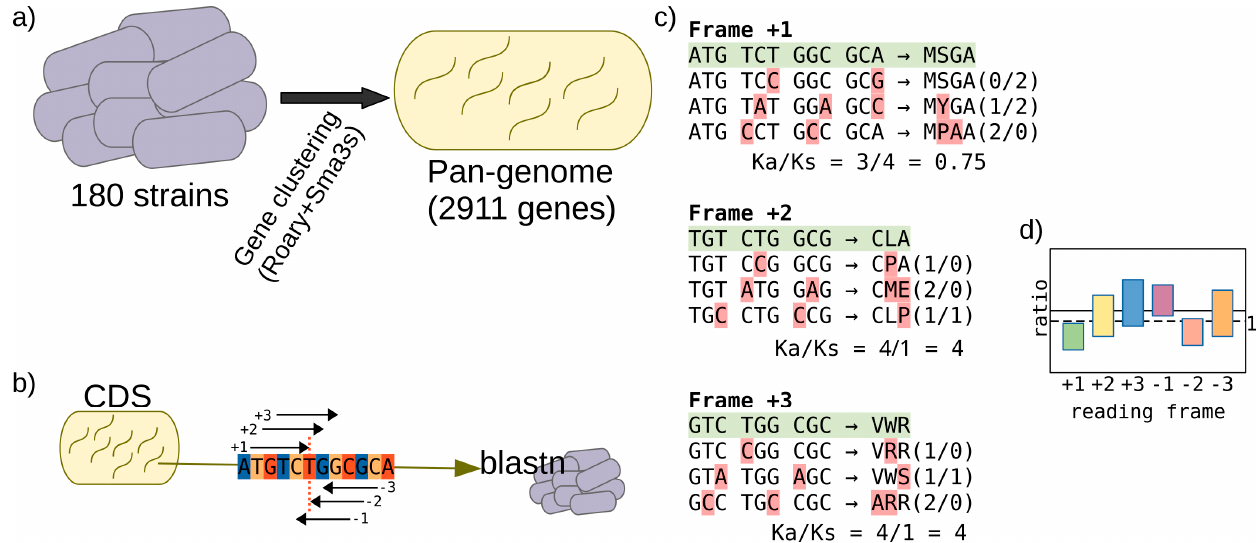
Figure 2. Pangenome details and procedure to calculate the Ka/KS ratio. ( a ) Number of available strains and genes in the pangenome previously obtained. ( b ) The six putative reading frames for each CDS in the pangenome are extracted, and homologous sequences are searched in all the strains (performing a similarity search with BLASTN). Note that the third position in codons from the frame +1 is also the third position of the frame − 2 (red dotted line). ( c ) Then, the Ka/Ks for each frame can be calculated starting from the multiple alignments of the homologs from each gene. The initial gene analyzed is highlighted in green, and nucleotide changes are highlighted in red. The number of nonsynonymous and synonymous changes is shown in parentheses. ( d ) Finally, the distribution of Ka/Ks ratios from all the genes in the pangenome can be shown, where we expect a value lower than 1 for most of the genes in the frame +1, and slightly higher values in the frame − 2. However, the other four frames should show values greater than 1.